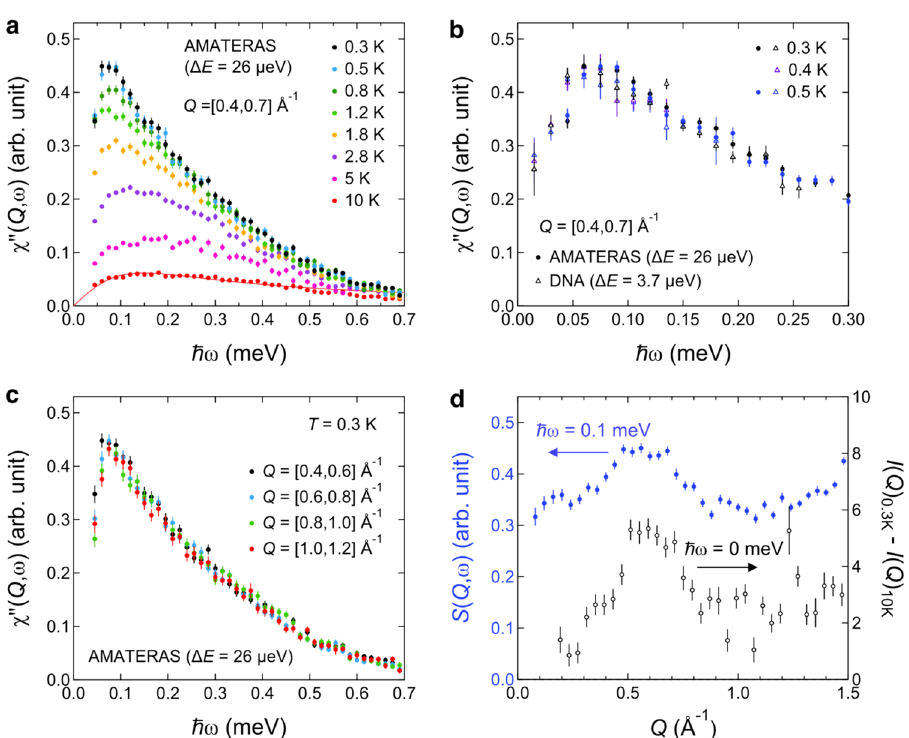
Figure 4. Energy, momentum and temperature dependence of magnetic excitation of glassy C4mimFeCl 4 . ( a ) Energy spectra corrected for the Bose factor, χ ′′ ( Q ,ω), in the glassy state in the temperature range of 0.3–10 K. Red solid curve represents the result of fit with the Debye relaxation model (see main text). ( b ) Energy spectra below T ≈ T SG obtained using two spectrometers with different energy resolutions (∆ E ). ( c ) Energy spectra at T = 0.3 K with different Q , where scale factors are multiplied for comparison. ( d ) Constant-ℏω cuts at 0.1 ± 0.04 meV (excitation peak) and 0 ± 0.015 meV (elastic scattering) for the 0.3 K data, where the magnetic elastic scattering was obtained by subtracting the data at 10